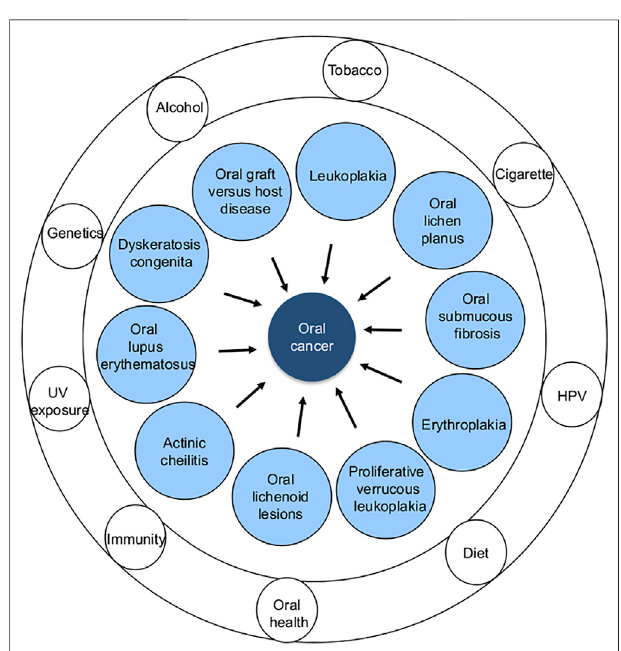
FIGURE 2 | Different types of OPMDs (inner circle) and common risk factors (outer rings) associated with oral cancer